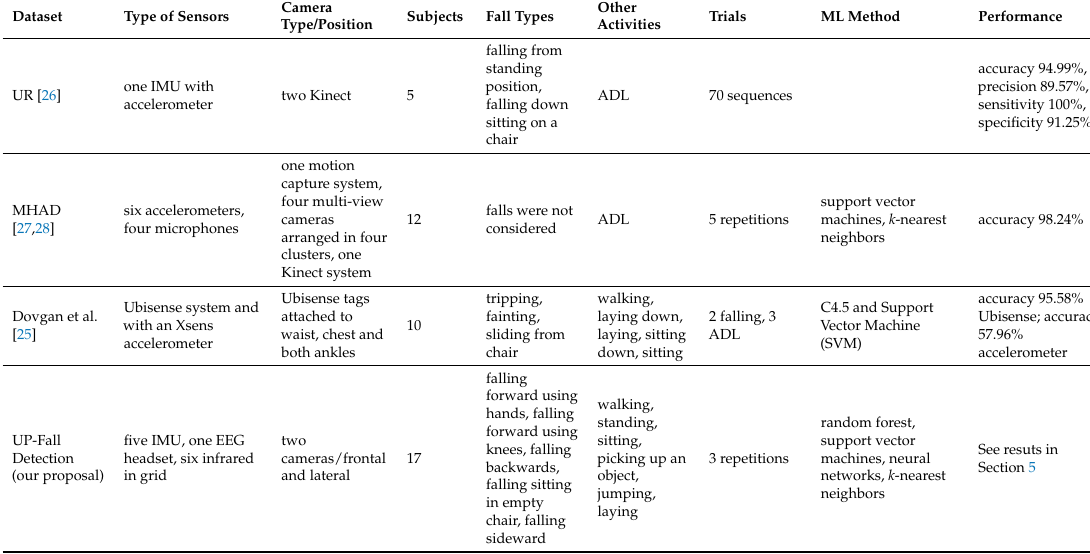
Table 3. Multimodal databases for fall